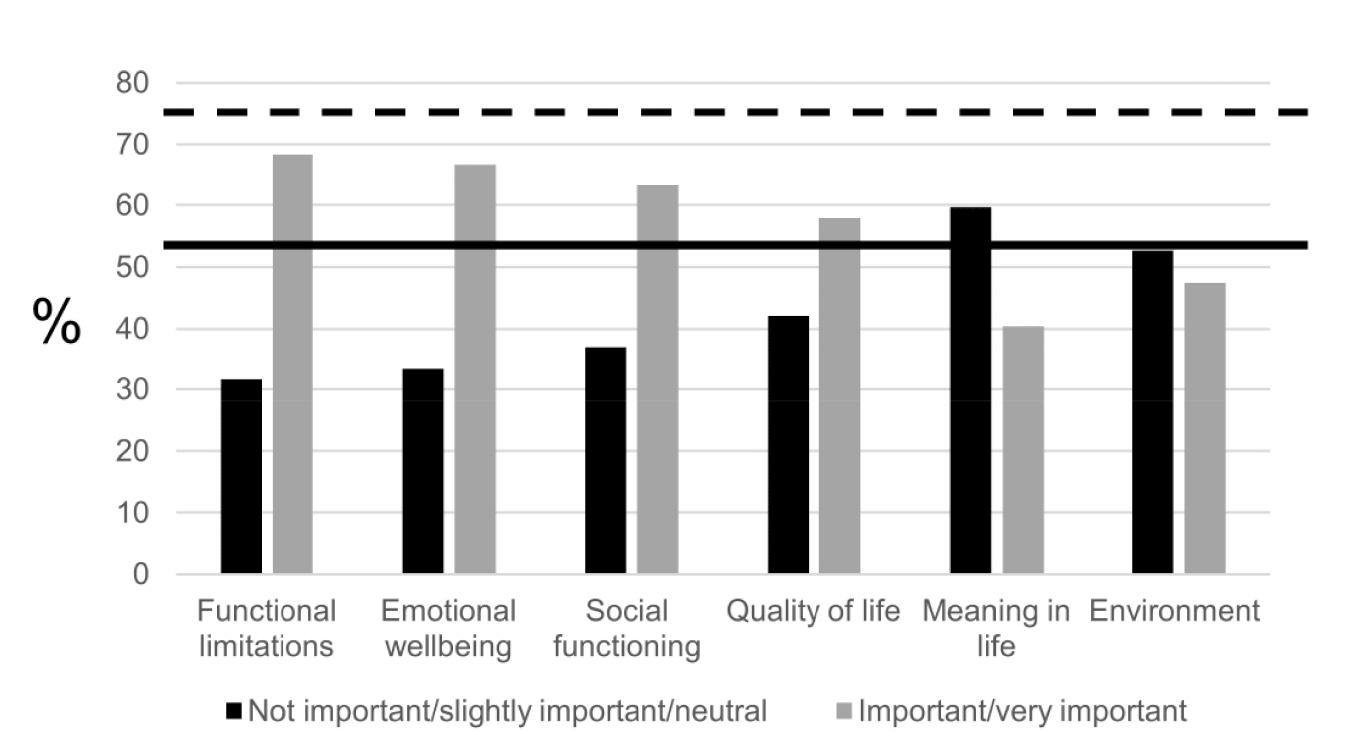
Fig 2. Round 1: Overview of the assessments of the health domains. Frequency distribution (%) of the importance to discuss each domain with healthcare professionals. The bold black line represents the 50% threshold. The bold black dotted line represents the 75%